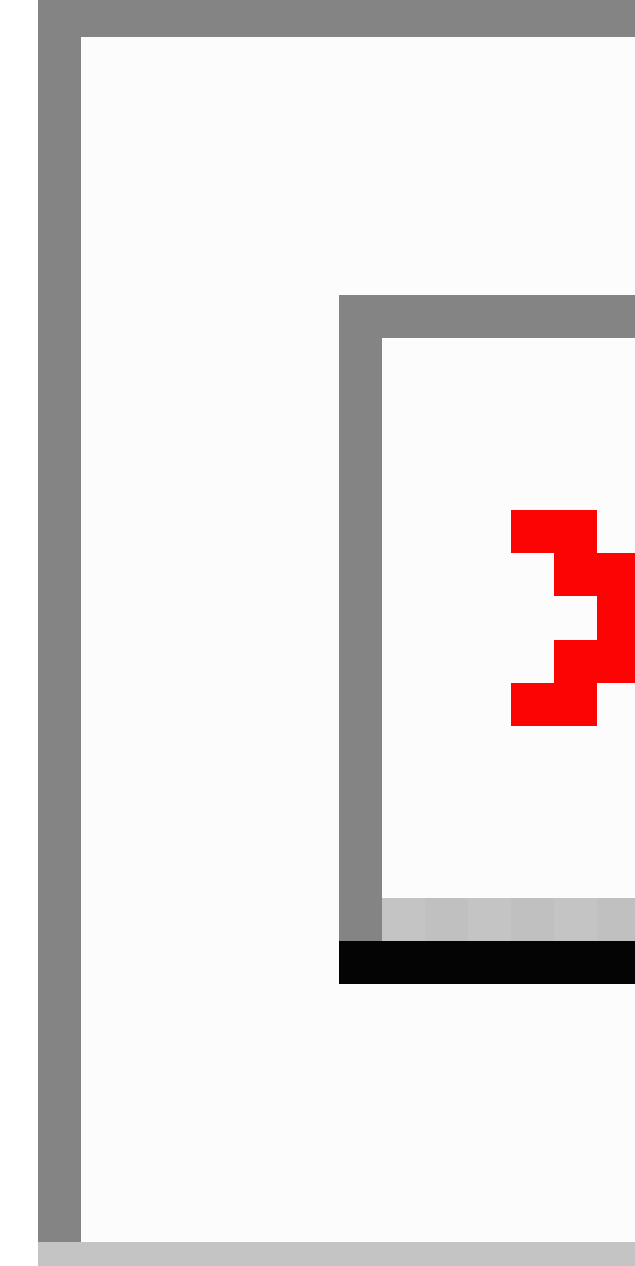
Figure 5. Mean change in weight (% of body weight)